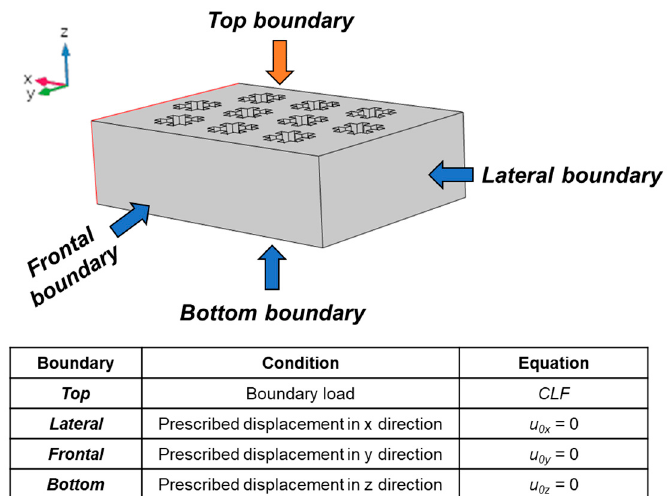
Figure 7. Schematic of the boundary conditions adopted in the FEA-based mechanical analysis.